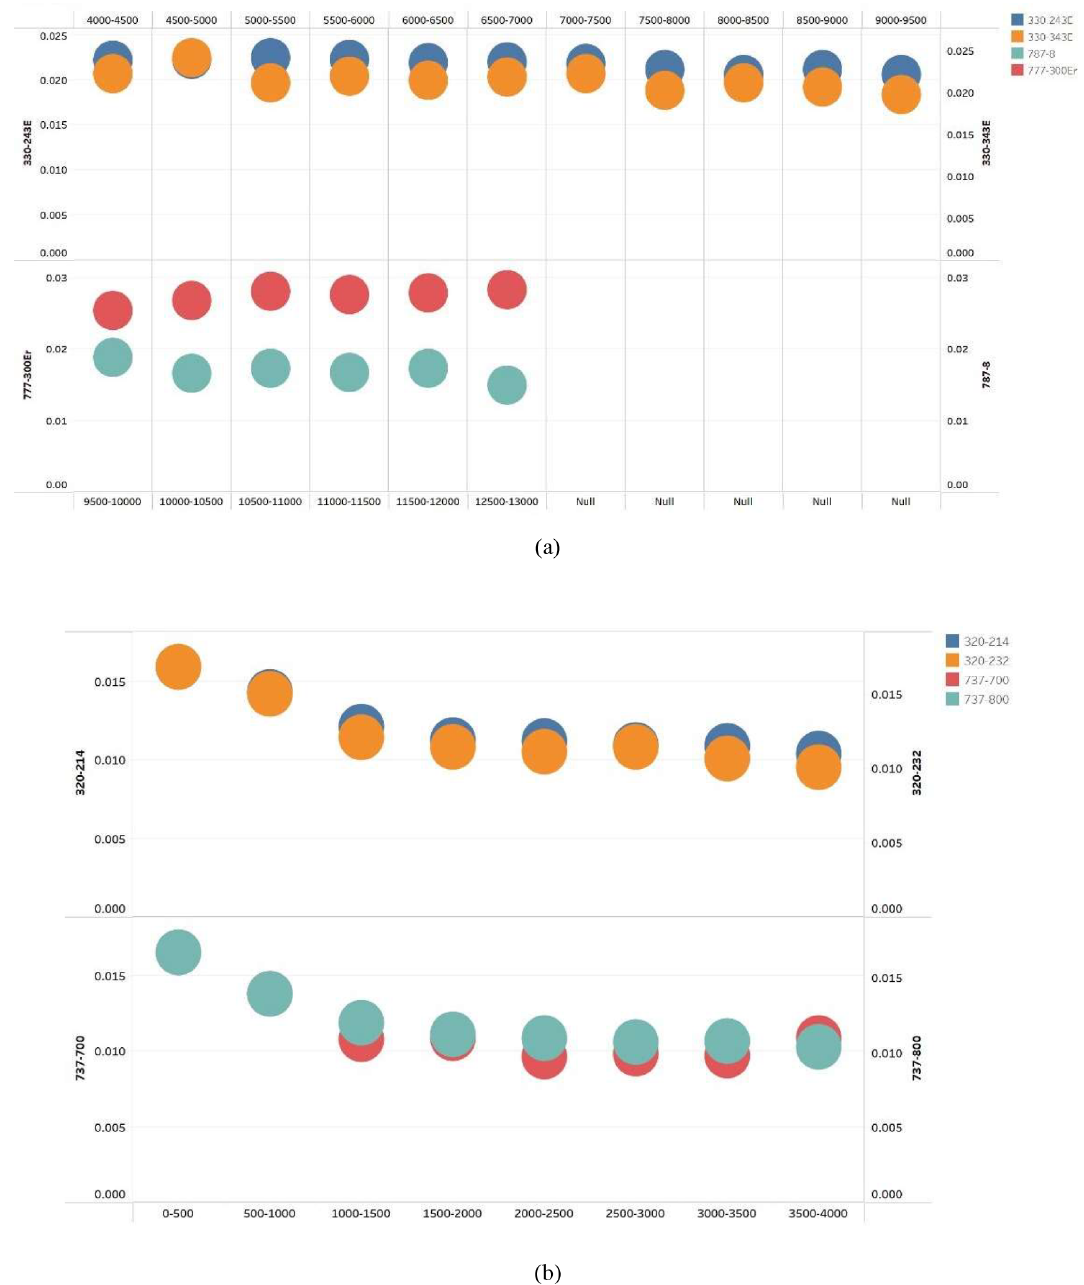
Figure 3. Carbon emission intensity of the aircraft (tkm − 1 ). (a) Comparison of 320-214 and 320-232 and 737-700 and 737-800. (b) Com- parison of 330-243E and 330-343E and 777-300ER, and 787-8.